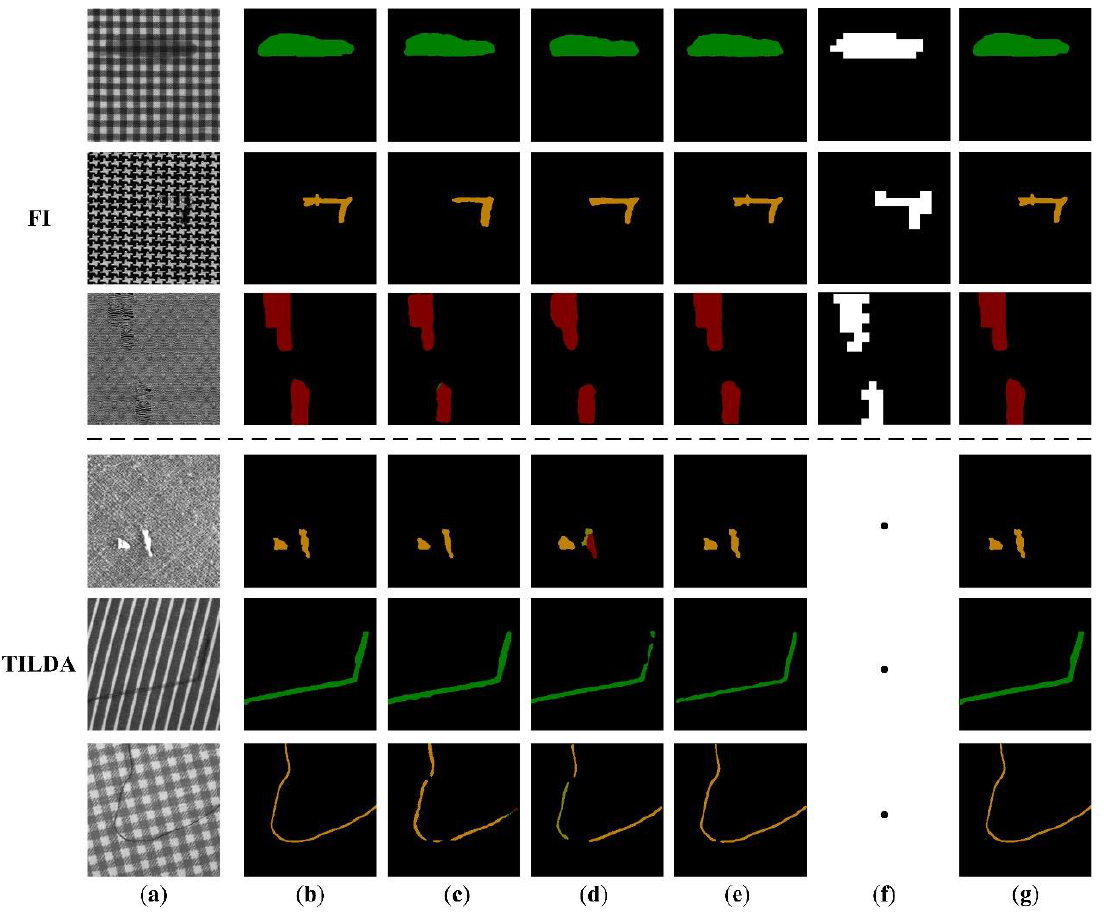
Figure 8. Visual comparison of different detection methods on different fabric samples. ( a ) Original image, ( b ) Ground truth, ( c ) FCN, (d) UNet, ( e ) Mobile-Unet, ( f ) LSTS, ( g ) RPDNet.